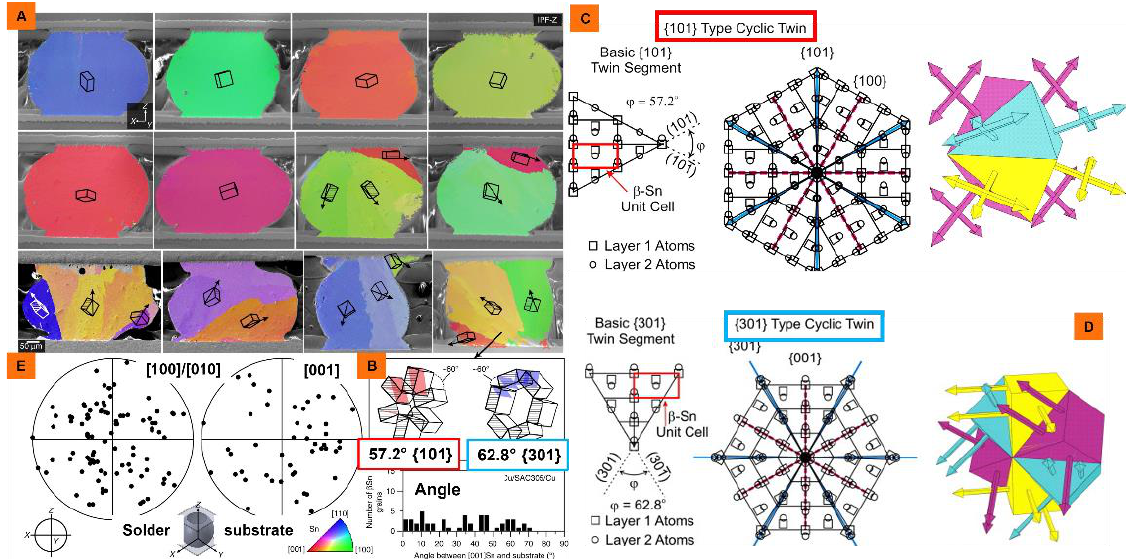
Figure 1. {101} ( A ) or {301} ( B ) type twins induced by CoSn 3 substrate, rotating 57.2° and 62.8° around [100], respectively ( C ) Projection view of Sn lattice onto the (0 1 0) plane, showing a basic {1 0 1} twin segment and a {1 0 1} cyclic twin nucleus. ( D ) Projection view of Sn lattice onto the (0 1 0) plane, showing a basic {3 0 1} twin segment and a {3 0 1} cyclic twin nucleus ( E ) <100> and <001> pole figures showing the highly variable β Sn grain orientations (adapted from [6,7,10]).